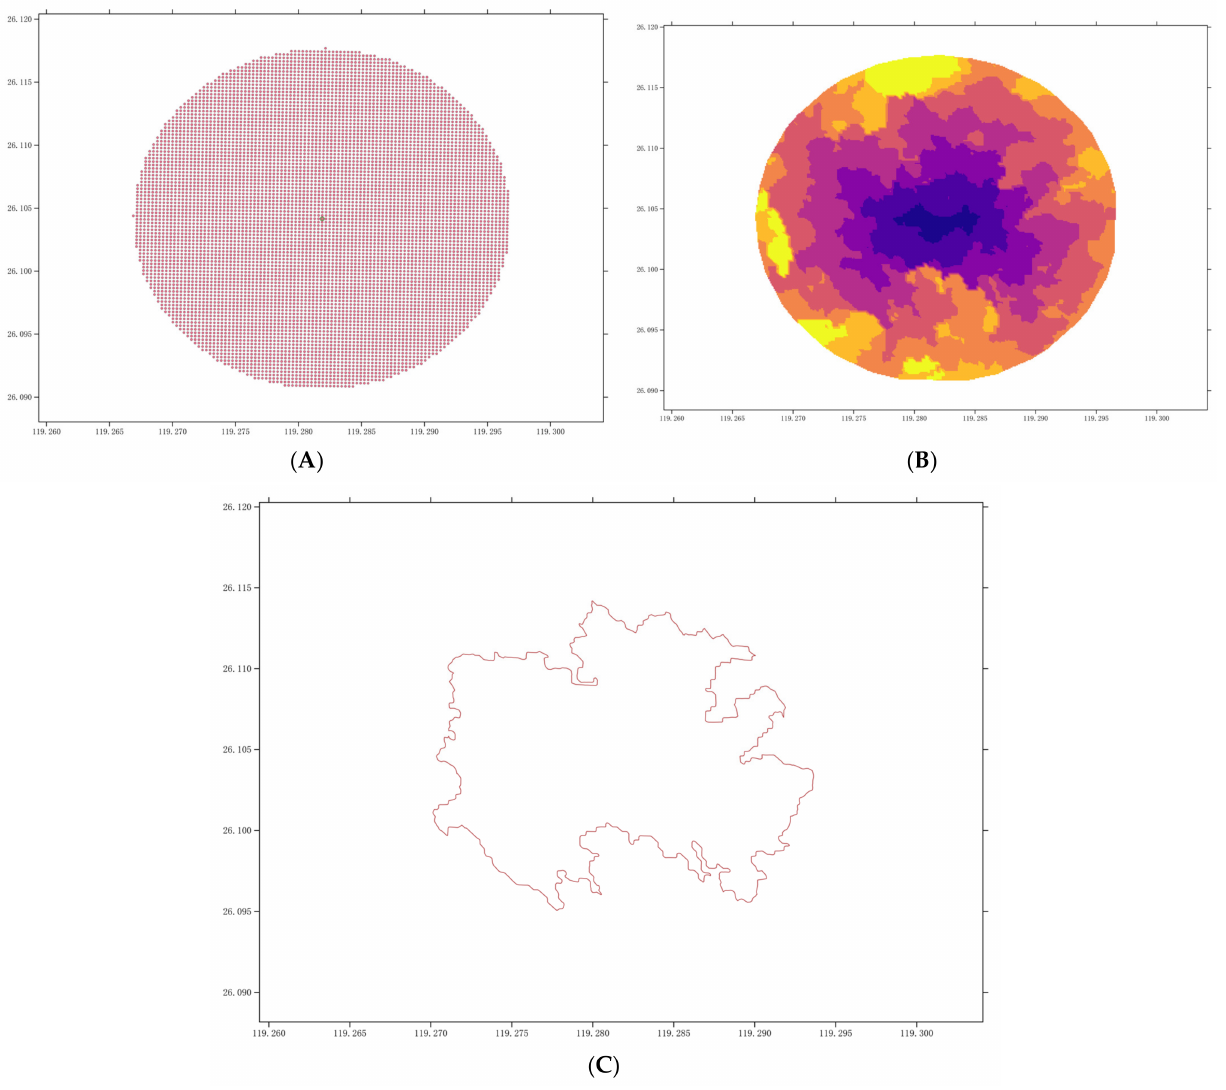
Figure 2. Examples of control point interpolation data. ( A ) Control point data. ( B ) Interpolation raster data. ( C ) Track contour line